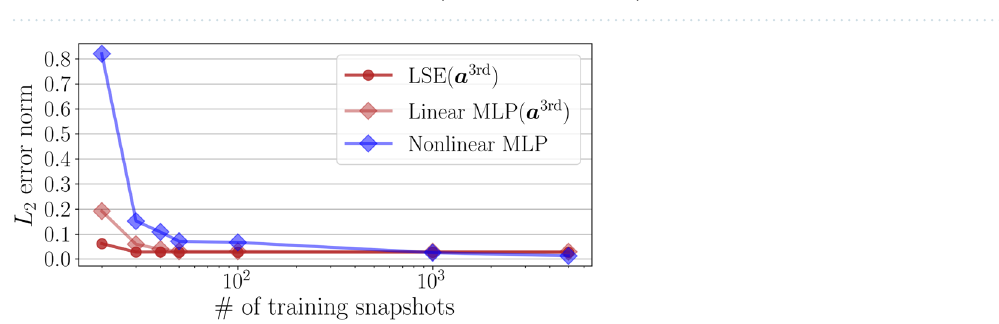
Figure 2. POD coefficients estimation from ( a ) 1st order coefficients a in = { a 1 , a 2 } and ( b ) 2nd and 3rd order coefficients, and ( c ) the L 2 error norm ε = || a out,ref − a out,est || 2 / || a out,ref || 2 .